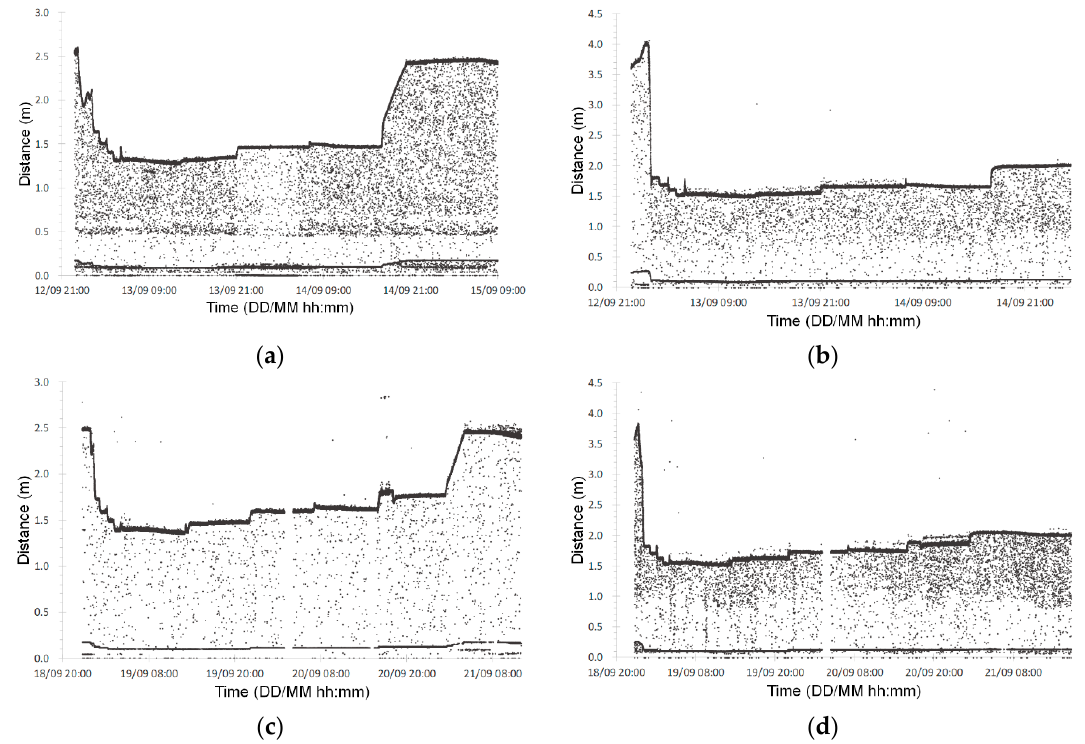
Figure 3. Measured raw data of the distance from the ultrasonic sensor to water surface for about 60 h. ( a ) Case of hydrograph 1—downstream bridge; ( b ) case of hydrograph 1—upstream weir; ( c ) case of hydrograph 2—downstream bridge; ( d ) case of hydrograph 2—upstream